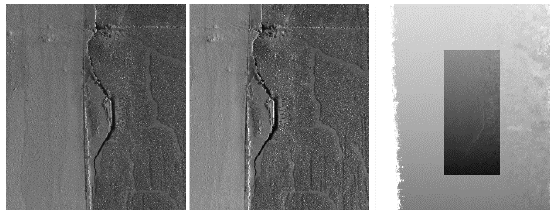
Figure 8. Detection and 3D extrapolation of a crack (3mm wide). 1 st and 2 nd images are the stereo-pair; 3 rd image: the